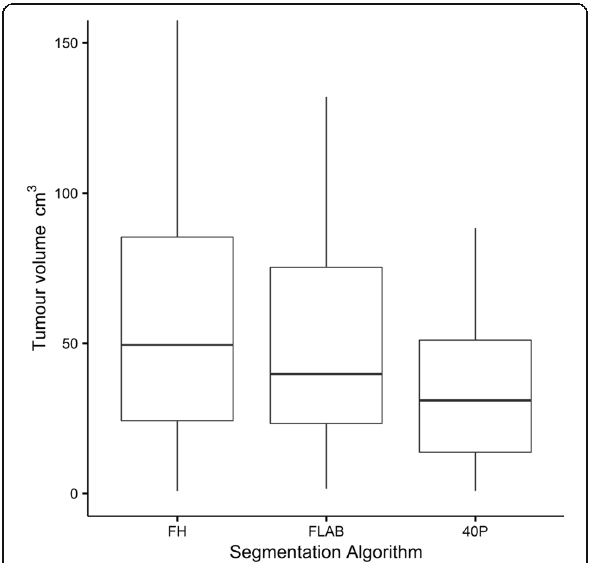
Fig. 1 Boxplots comparing the three segmentation algorithms in volume measurement. The boxes represent the interquartile range (IQR). Horizontal lines through the boxes show median values. The whiskers represent values within 1.5*IQR. 40P = 40% of maximum intensity threshold. FH freehand, FLAB fuzzy locally adaptive